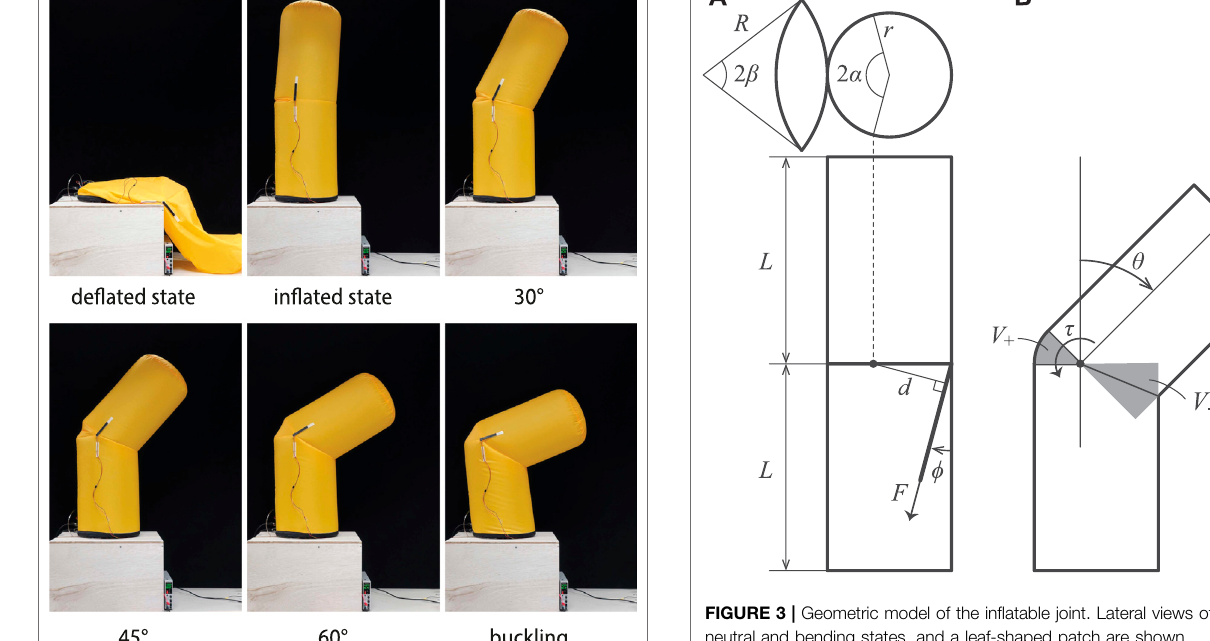
( Figure 2A ). Bilateral joints have leaf-shaped patches on both sides that can bend to either side from the initial state ( Figure 2D ). The size of the leaf-shaped patch is related to the range of motion ( Figures 2E,F ).